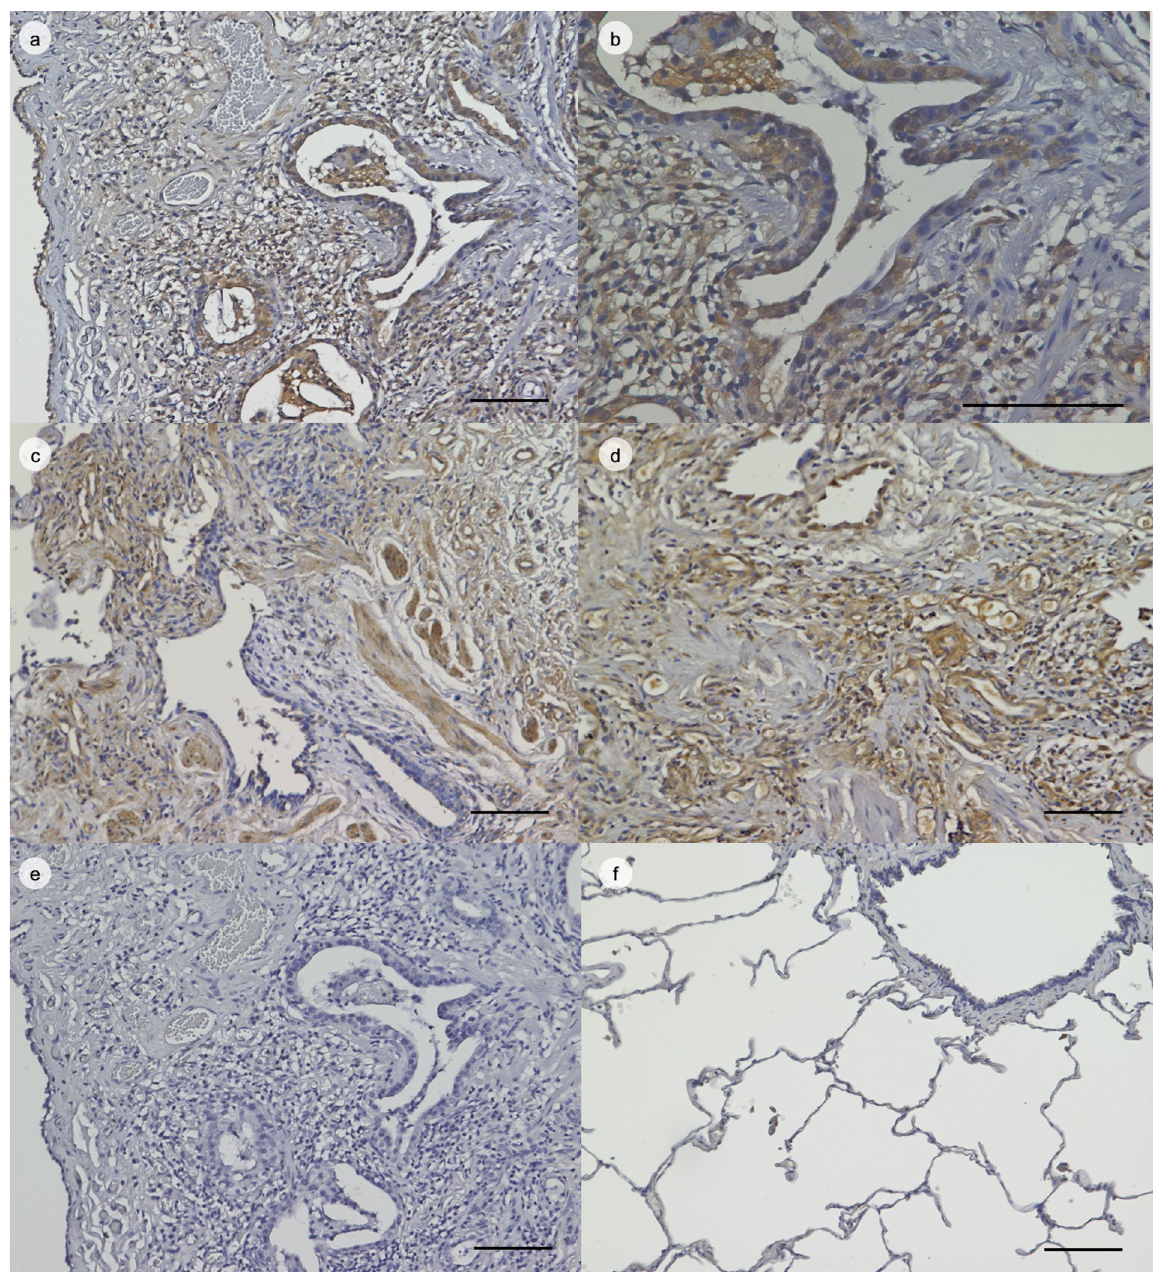
Fig 1. Immunohistochemical expression of IL-18BP in IPF and control lungs. (a, c, d) Immunohistochemical staining of IPF lung tissue with anti-IL-18BP antibody presented at x100 magnification. (b) The same field of view as in panel (a) presented at x400 magnification. (e) Immunohistochemical staining of IPF lung tissue with rabbit IgG presented at x100 magnification. (f) Immunohistochemical staining of control lungs with anti-IL-18BP antibody presented at x100 magnification. Scale bar = 100 μ m. IL-18BP: interleukin-18 binding protein, IPF: idiopathic pulmonary